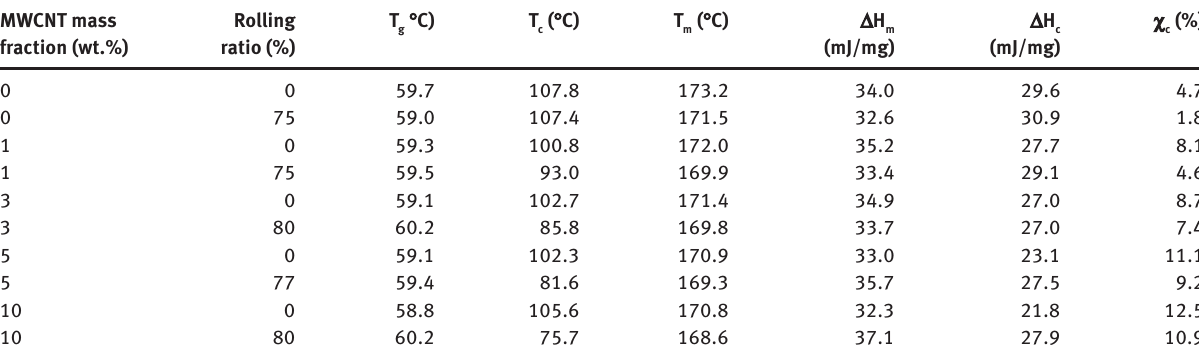
Table 3: Differential scanning calorimetry data measured on unrolled and 75% rolled PLA/MWCNT composite specimens. MWCNT mass fraction